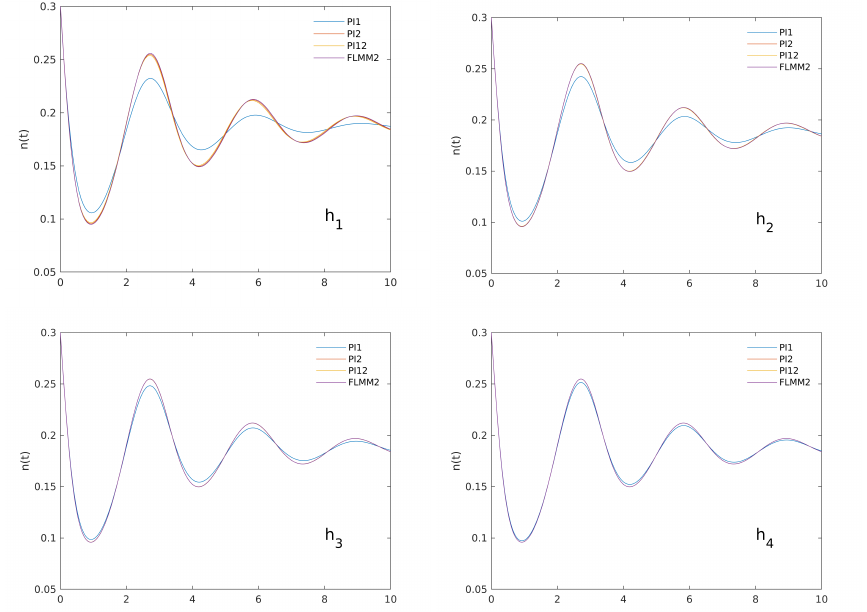
Figure 3. Details of the initial part of the trajectories shown in the left panel of Figure 2 as re- constructed by all the numerical methods for decreasing timesteps h 1 , h 2 , h 3 , h 4 . The lowest order approximation PI1 clearly shows more damped oscillations, and only for the smallest timestep it agrees with the other methods, whose results are practically identical.